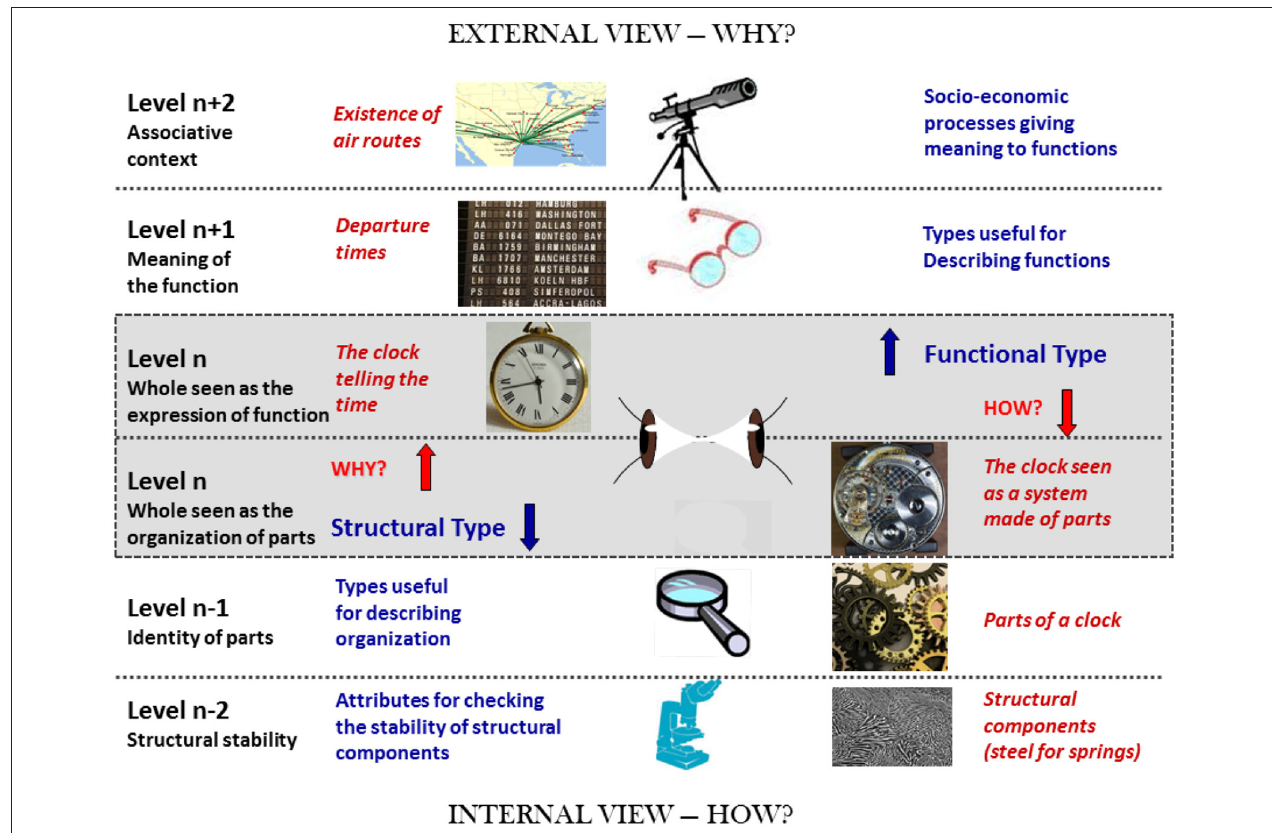
FIGURE 1 | Scale of perception and representation of the functional and structural type associated with a clock.